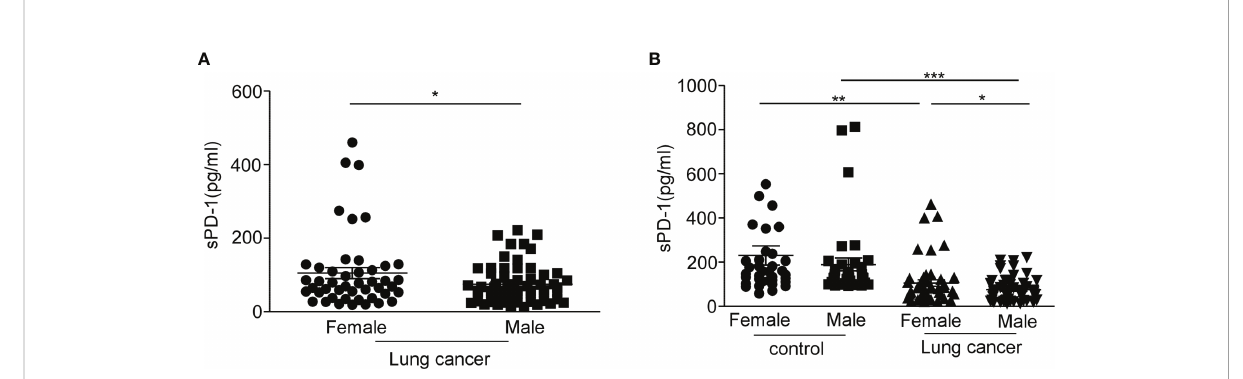
FIGURE 2 The level of serum sPD-1 in female lung cancer patients is higher than that in male patients. Serum sPD-1 levels were examined by ELISA. (A) The concentration of soluble PD-1 in serum (pg/ml) was analyzed in female and male non-small cell lung cancer patients. (B) The serum levels of sPD-1 (pg/ml) were detected in female and male controls. * P < 0.05, ** P < 0.005, *** P < 0.0001; Mann – Whitney test (two-tailed) and non-paired Student ’ s t